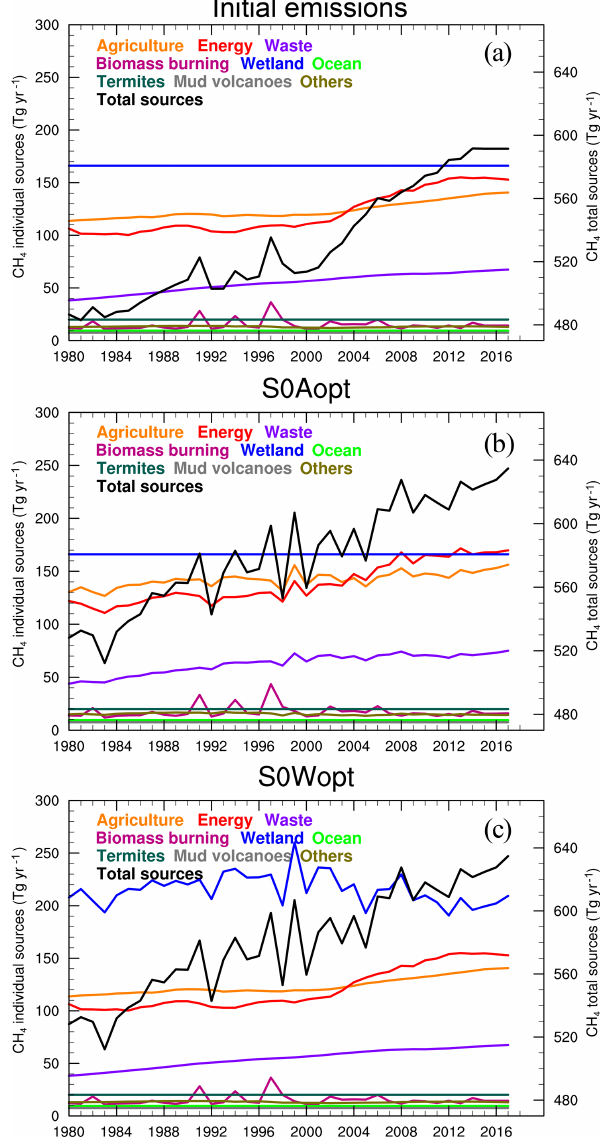
Figure 1. Time series of methane emissions from the initial methane inventories (a) and optimized methane emissions on anthropogenic sectors (S0Aopt, b ) and wetland sectors (S0Wopt, c ) for the period of 1980–2017. The emissions for major sectors are shown on the left y axis, including the agriculture sector, energy production sec- tor, waste sector, biomass burning sector, wetland sector, ocean and nearshore fluxes, termites, mud volcanoes, and other sources (i.e., industrial processes, surface transportation, international shipping, residential, commercial, and others). The total methane emissions from the initial emission inventories and optimization (black line) are shown on the right y axis.